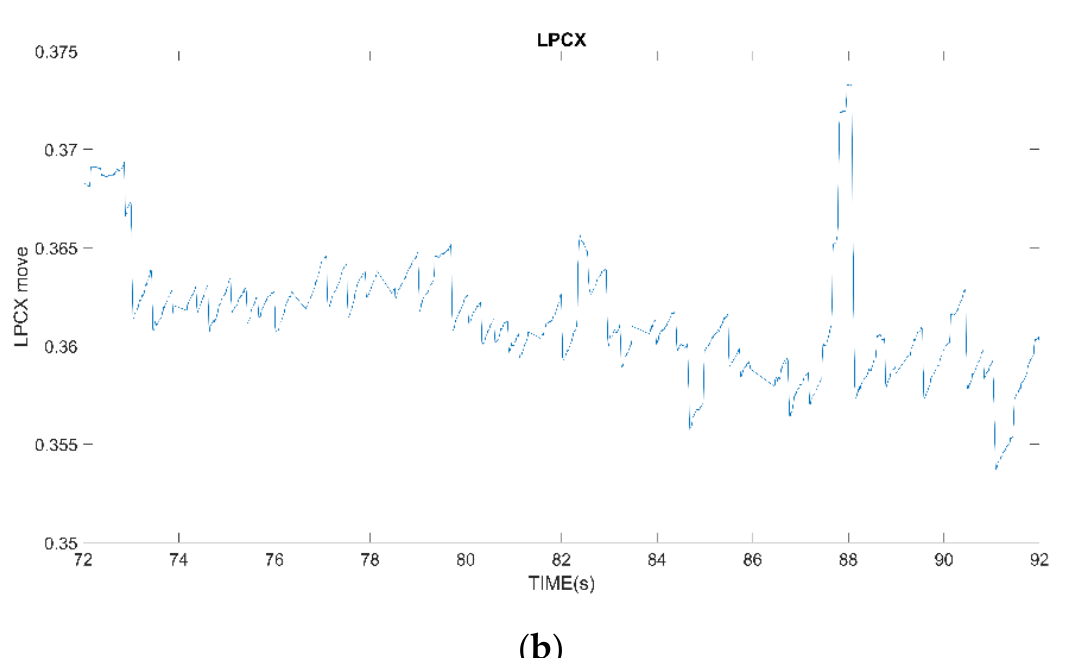
Figure 3. ( a ) Unable to look at the same level; the drop from the starting position is too large; ( b ) The eyeball drifts involuntarily, and a signal with excessive displacement is detected.